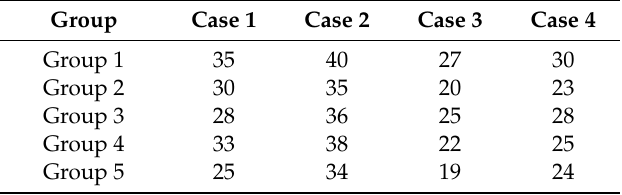
Table 2. Quantity of associated Japanese words of every group in di ff erent illumination